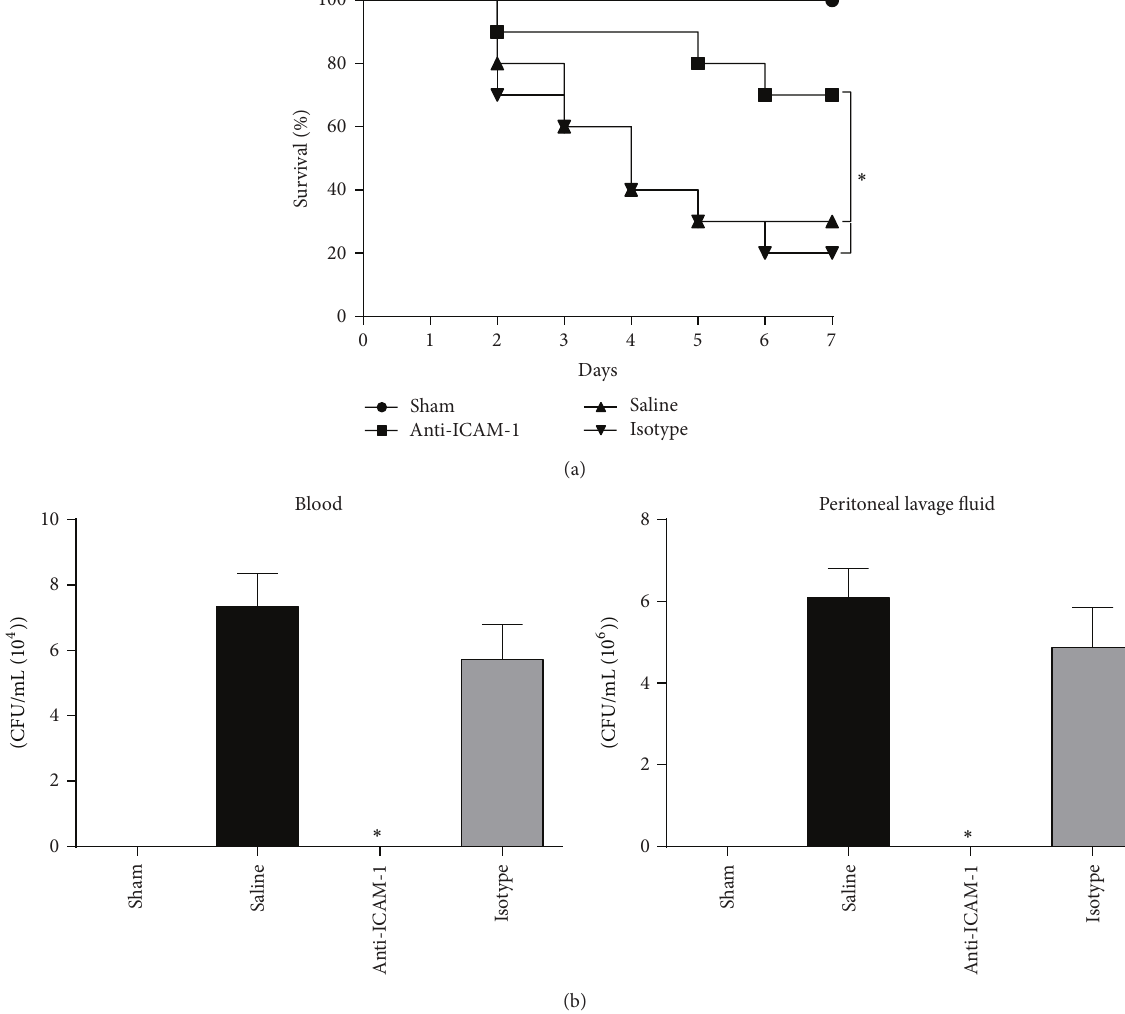
Figure 2: Anti-ICAM-1 antibody treatment improved survival (a) and bacterial clearance (b) in CLP mice. (a) The 7-day survival rates were compared among anti-ICAM-1 antibody treated CLP mice, isotype antibody treated CLP mice, saline treated mice, and sham-operated mice. 𝑛 = 10 per each group. ∗ 𝑃 < 0.05 when anti-ICAM-1 antibody treated mice were compared with mice treated with isotype antibody or saline. (b) Bacterial clearance was compared among anti-ICAM-1 antibody treated CLP mice, isotype antibody treated CLP mice, saline treated mice, and sham-operated mice 24 h after surgery. 𝑛 = 6 per each group. PLF: peritoneal lavage fluid. ∗ 𝑃 < 0.05 when anti-ICAM-1 antibody treated mice were compared with mice treated with isotype antibody or saline. Bars represent the mean ±